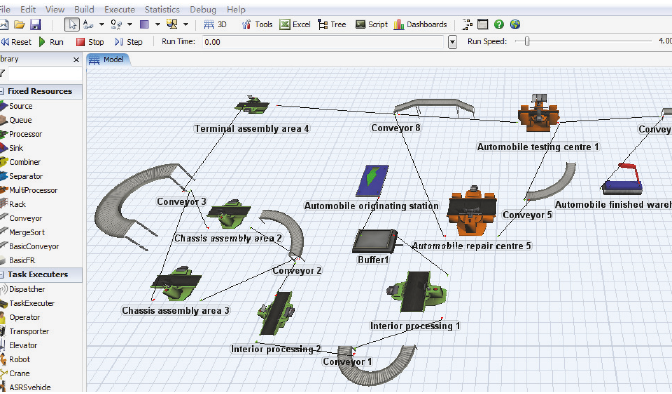
Figure 9: Optimization model of mixed model automobile assembly